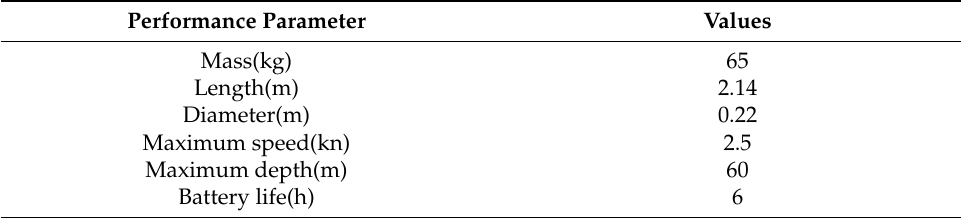
Table 1. Performance parameters of AUV “T-SEA I”.